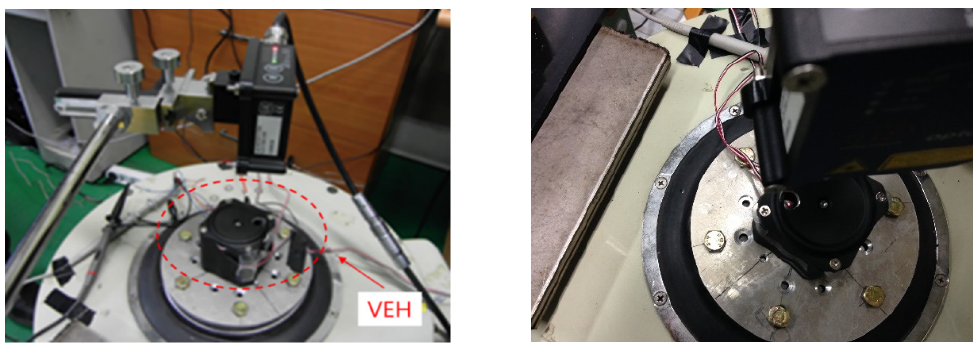
Figure 11. The test of the VEH device in the laboratory and the laser displacement meter for measuring the moving displacement.